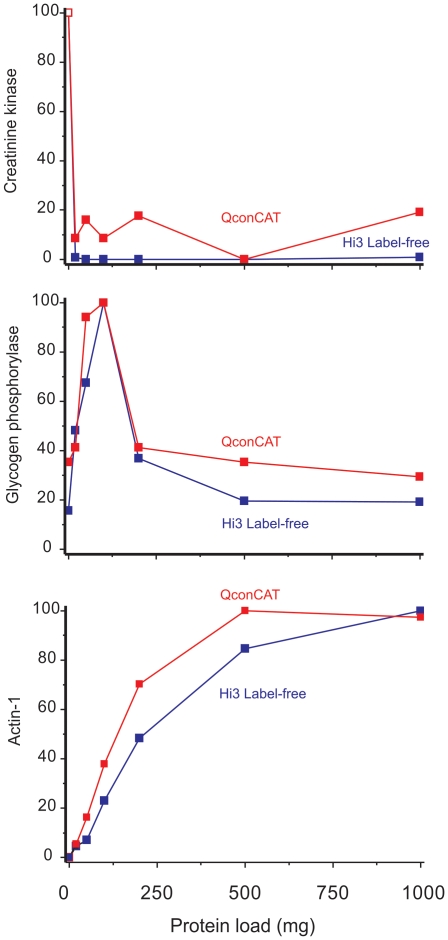
Comparison of individual protein behavior by QconCAT and label-free quantification.Prospectrum II beads were exposed to very high levels (up to 1000 mg protein/20 mg beads) and bound proteins were analyzed by quantitative proteomics, using both a label free approach in addition to a labelled internal standard (QconCAT). For three representative proteins, the binding behavior (reduction in representation: creatine kinase, transient binding: glycogen phosphorylase b and gradual accumulation: actin-1) was assessed by both quantitative approaches (QconCAT: open squares, label free: filled squares). To aid comparison, data are presented as a percentage of the highest amount of bound protein obtained in each analysis.